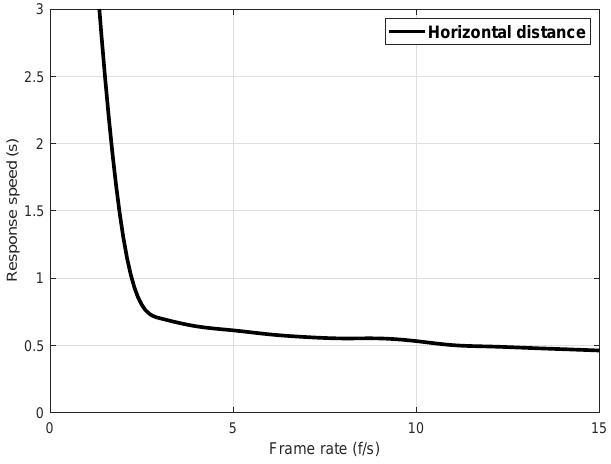
Figure 12. Image processing frame rate and PTZ response speed